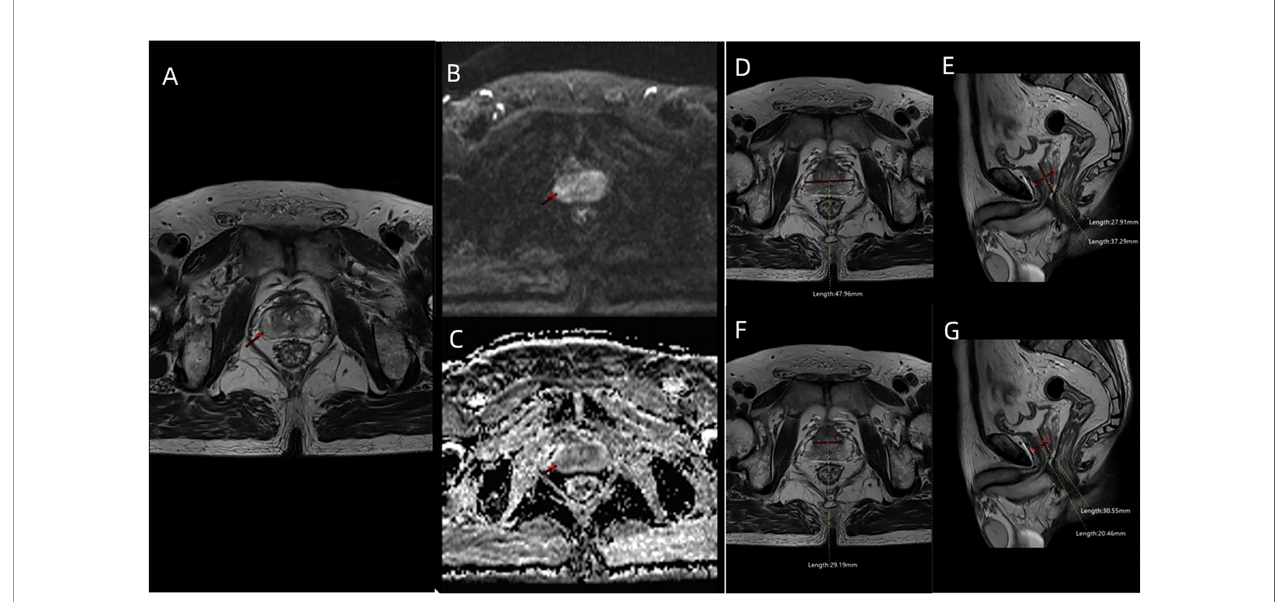
FIGURE 2 | The MRI images including (A) T2WI sequence, (B) DWI sequence, and (C) ADC sequence of a patient (age: 66 years; PSA: 7.8 ng/ml; f/tPSA: 0.138; ISUP GG: 2) with PIRADS 3 ROI in the right lateral posterior of peripheral zone. (D) Maximum transverse diameter of prostate (47.96 mm) measured on axial T2WI, and (E) maximum longitudinal diameter (37.29 mm) and maximum AP diameter (27.91 mm) of prostate measured on mid-sagittal T2WI. (F) Maximum transverse diameter of transitional zone (29.19 mm) measured on axial T2WI, and (G) maximum longitudinal diameter (30.55 mm) and maximum AP diameter (20.46 mm) of transitional zone measured on mid-sagittal